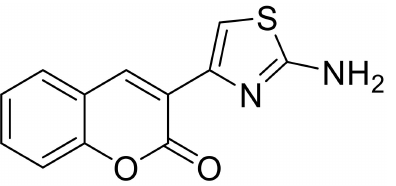
Figure 21. Structure of 2-(2-amino-1,3-thiazol-4-yl)-3H-benzo[f]chromen-3-one.